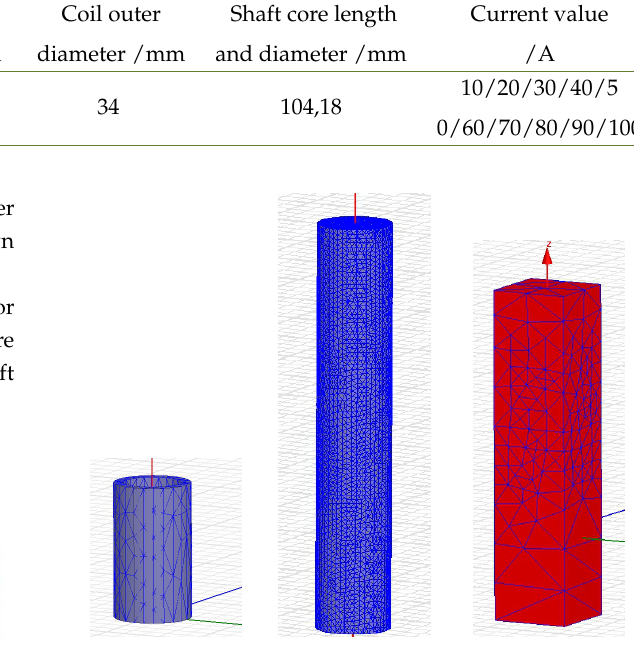
Fig. 5. Three dimensional model of the motor (a- Coil mesh model, b- Shaft core mesh model, c- Scope grid